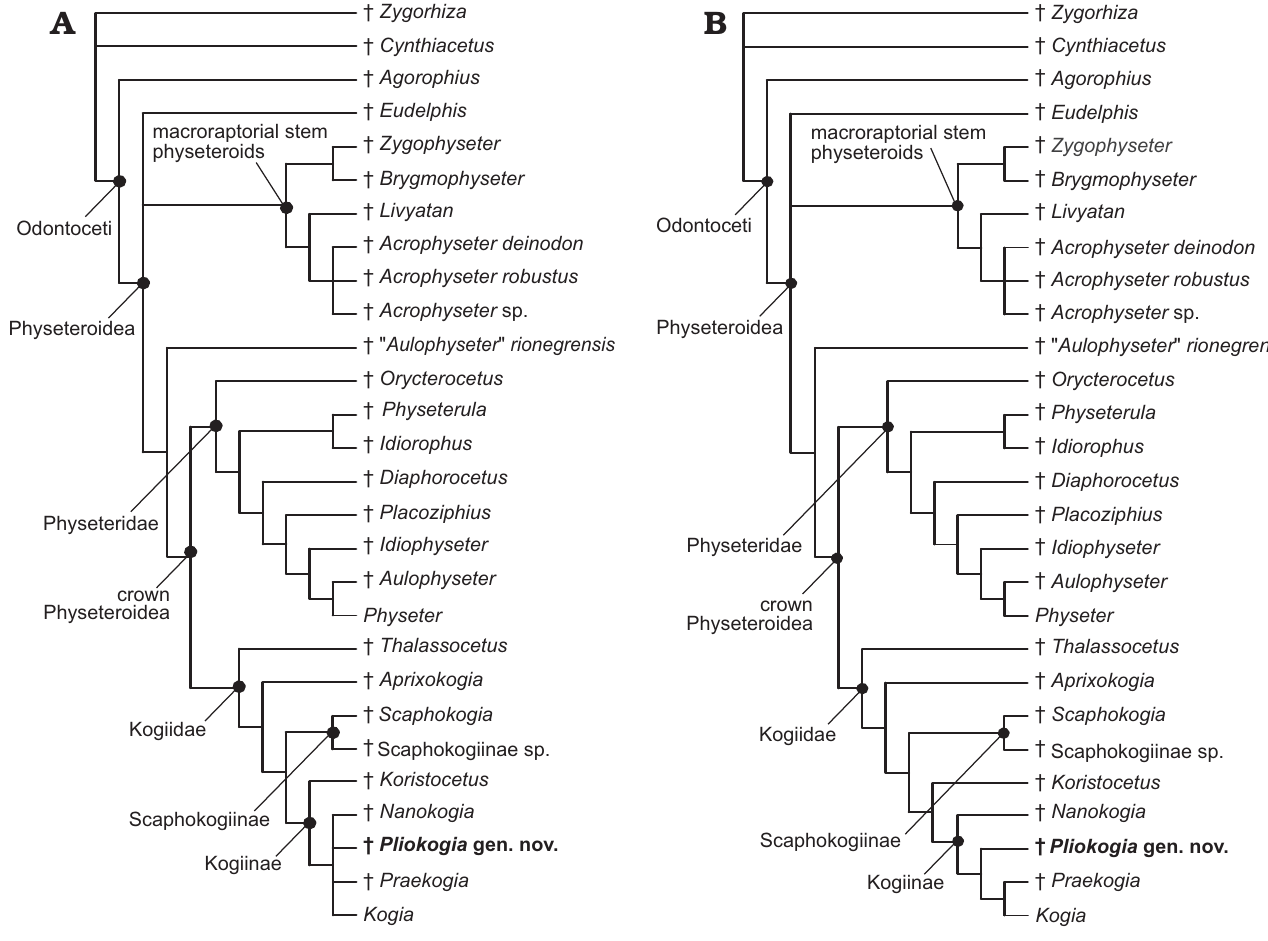
Fig. 9. Phylogenetic relationships of Pliokogia apenninica gen. et sp. nov. with other physeteroids. A . Strict consensus tree. B . 50% majority-rule consensus tree. Acrophyseter sp. refers to MUSM 2182, a partial skull from the site of Cerro Los Quesos (upper Miocene, Pisco Formation, Peru); Scaphokogiinae sp. refers to MUSM 3291 and MUSM 3405, two partial skulls from the sites of Cerro Los Quesos and Cerro Blanco, respectively (upper Miocene, Pisco Formation, Peru), representing a new form of Kogiidae sharing similarities with Scaphokogia cochlearis (see the SOM file for further details). Extinct genera and species are marked by a dagger